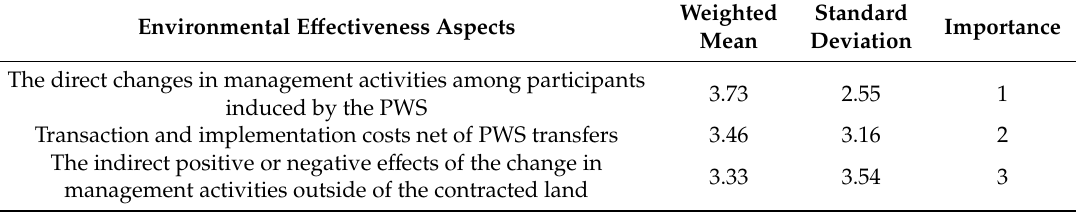
Table 7. The level of importance of the environmental aspects of PWS schemes design